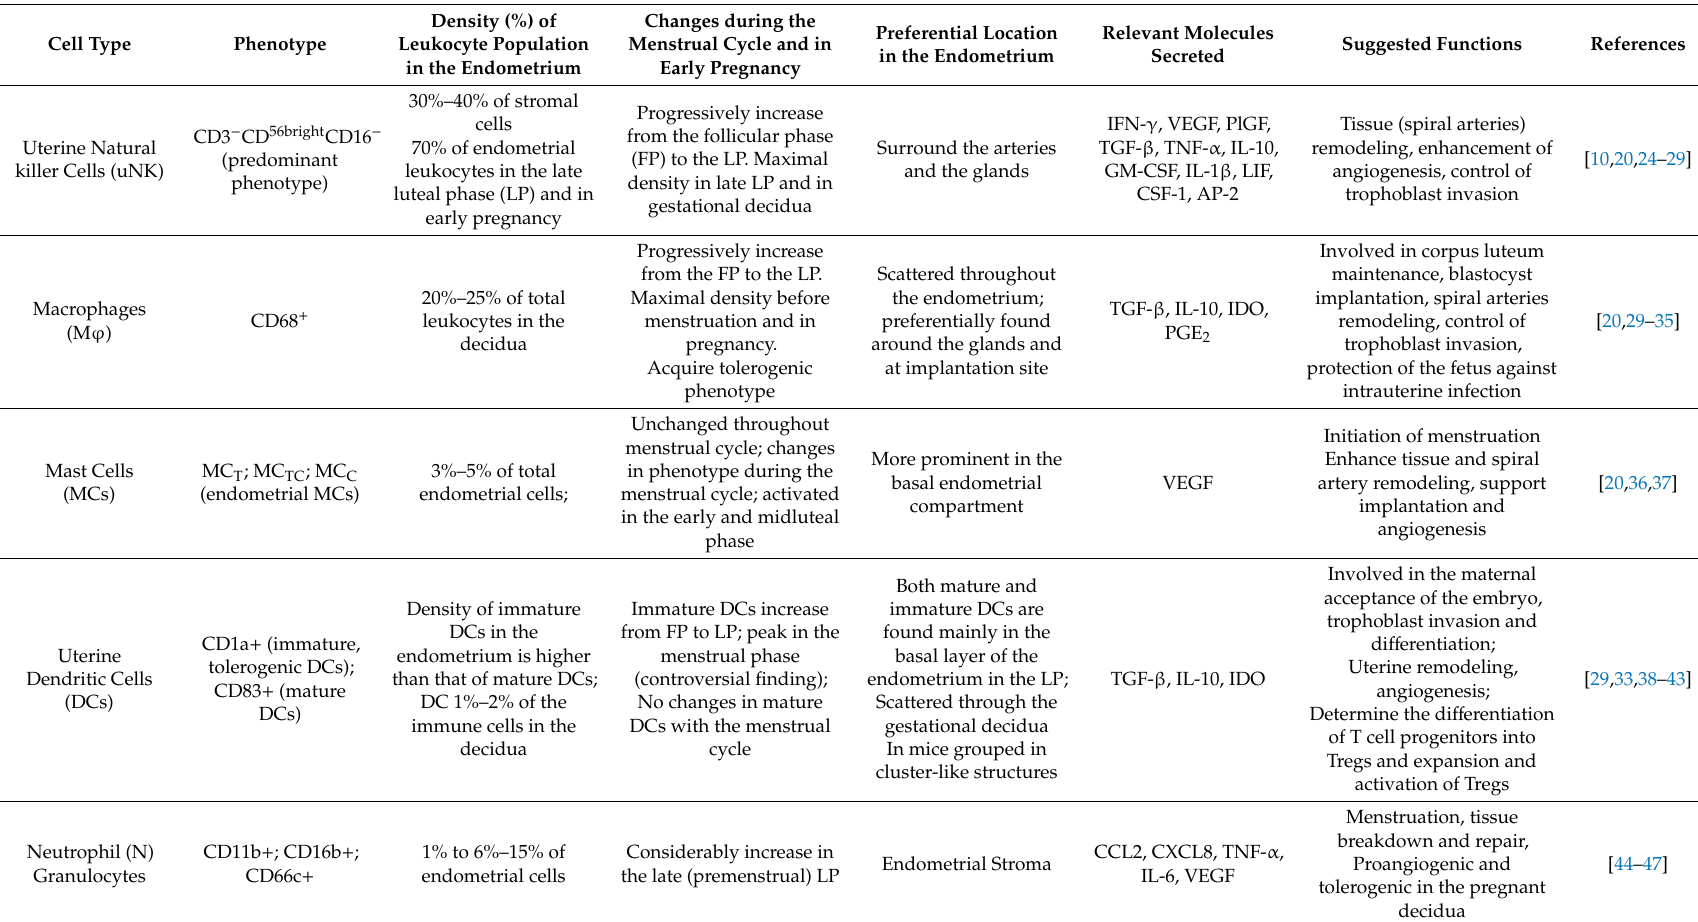
Table 2. Overview of the relevant cells of the innate immune system in the endometrium and decidua with their major reproductive